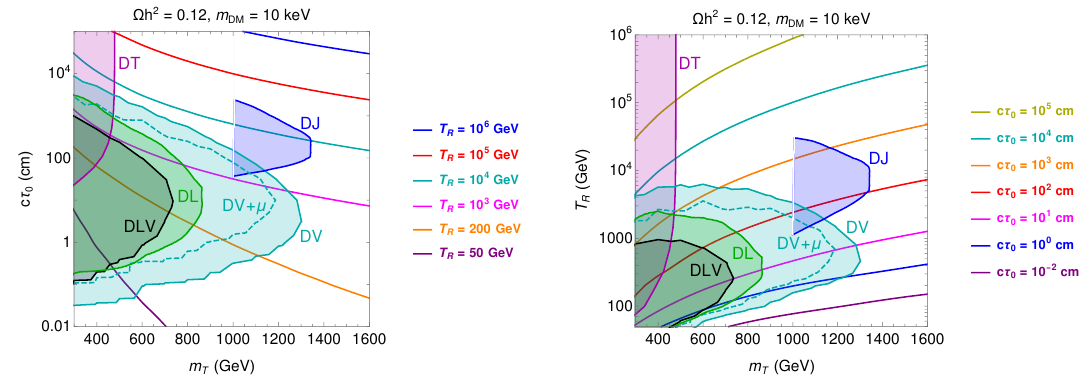
Figure 12. Contours of the value of T R accounting for the whole DM relic abundance in the ( m ) plane (left), contours of the neutral mediator lifetime cτ in the ( m ) plane (right), T , cτ 0 0 T , T R for the singlet-triplet DM model with m = 10 keV. The value of T associated to a given ( m ) χ R T , cτ 0 provides an upper bound on T for any dark matter mass as m & 10 keV due to small scale R χ structures constraints. The colored areas are excluded by LHC searches for displaced vertices + MET (blue), displaced vertices + µ (dashed blue), delayed jets (dark blue), displaced lepton vertices (black), displaced leptons (green), and the disappearing tracks